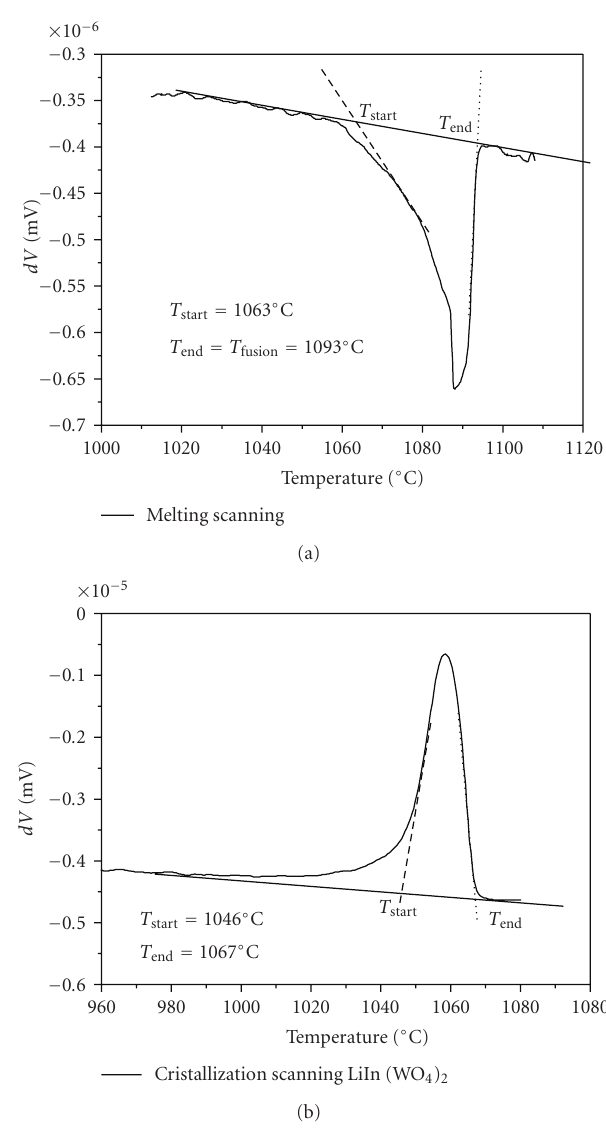
Figure 2: DTA curves of pure LiIn(WO 4 ) 2 during the (a) heating cycle and (b) cooling cycle.